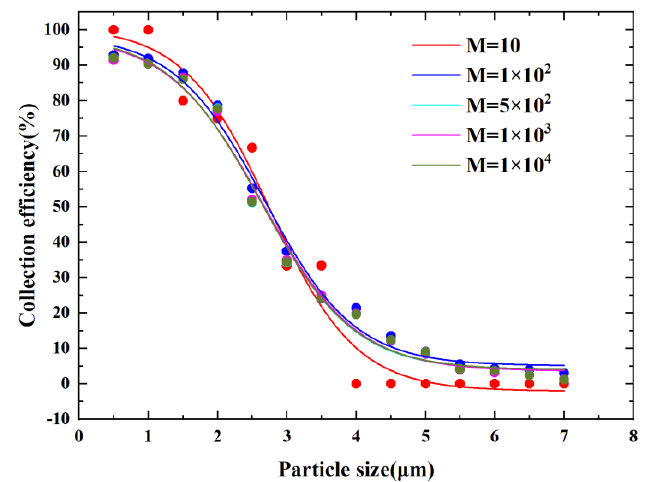
Figure 2. Grid irrelevance verification.